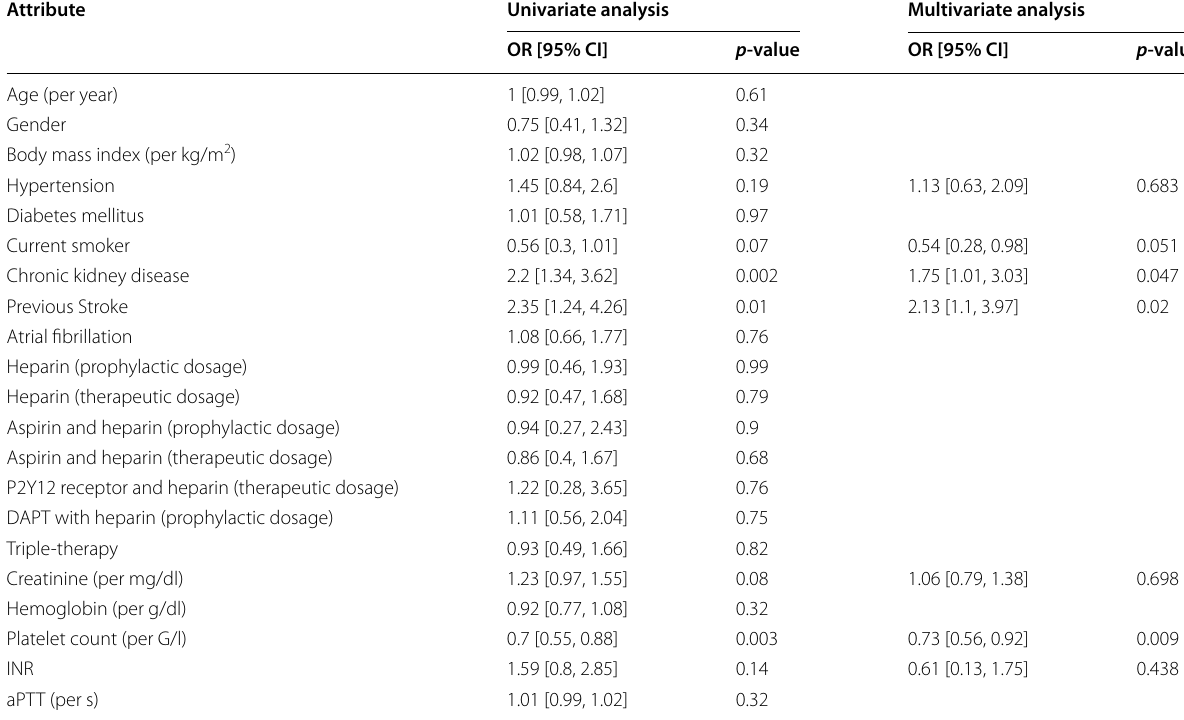
Table 3 Predictors of bleeding occurrence during and after PDT